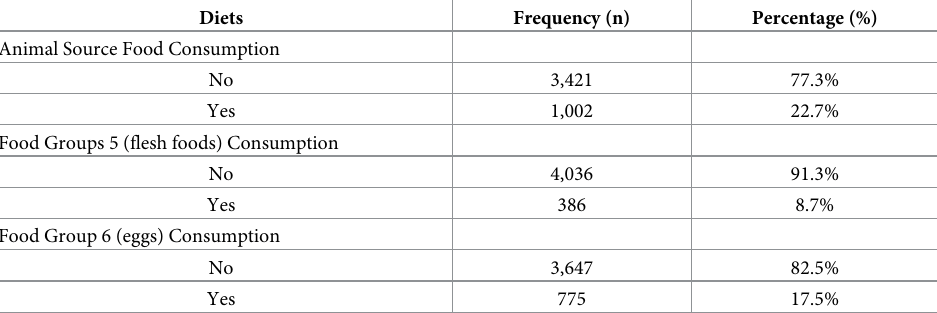
Table 2. ASF consumption among children aged 6–23 months in Ethiopia: Based on pooled data from 2016 and 2019 Ethiopia Demographic and Health Survey (n = 4,423).